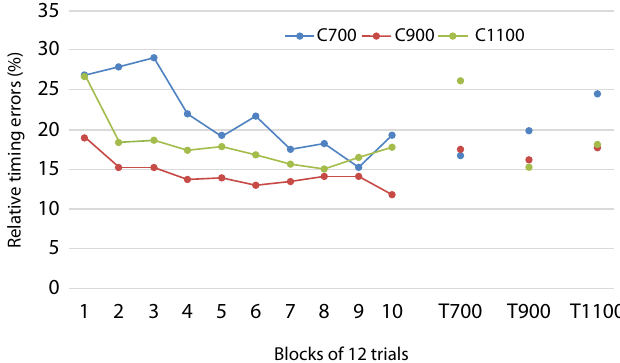
Figure 7 . Relative timing errors ( A E prop) in acquisition (blocks 1-10), Constant 700 ms test (T700), Constant 900 ms test (T900) and Constant 1.100 ms test (T1100).